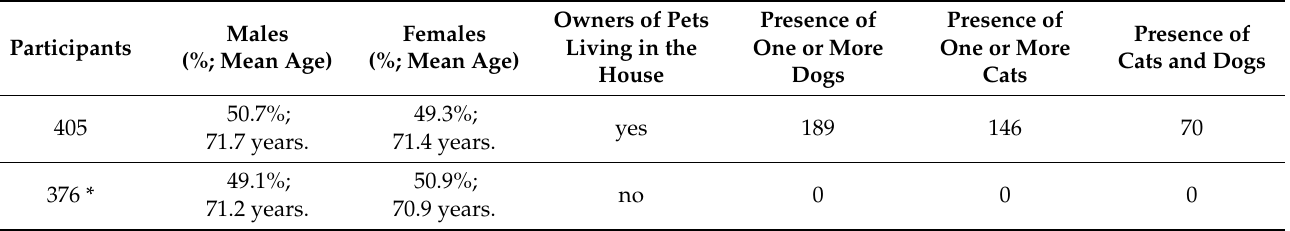
Table 1. Details on pet ownership in the elderly (* this number included both 235, not owners of pets and 141 owners of pets who do not live in the